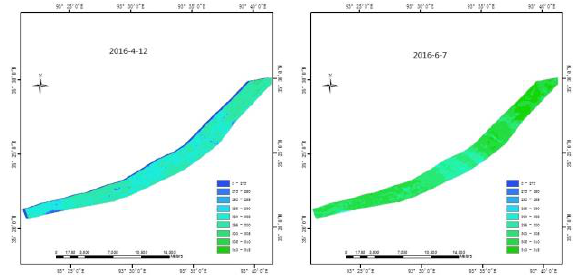
Figure 4. LST distributions derived from Landsat ETM+ and TM 8 over the study area